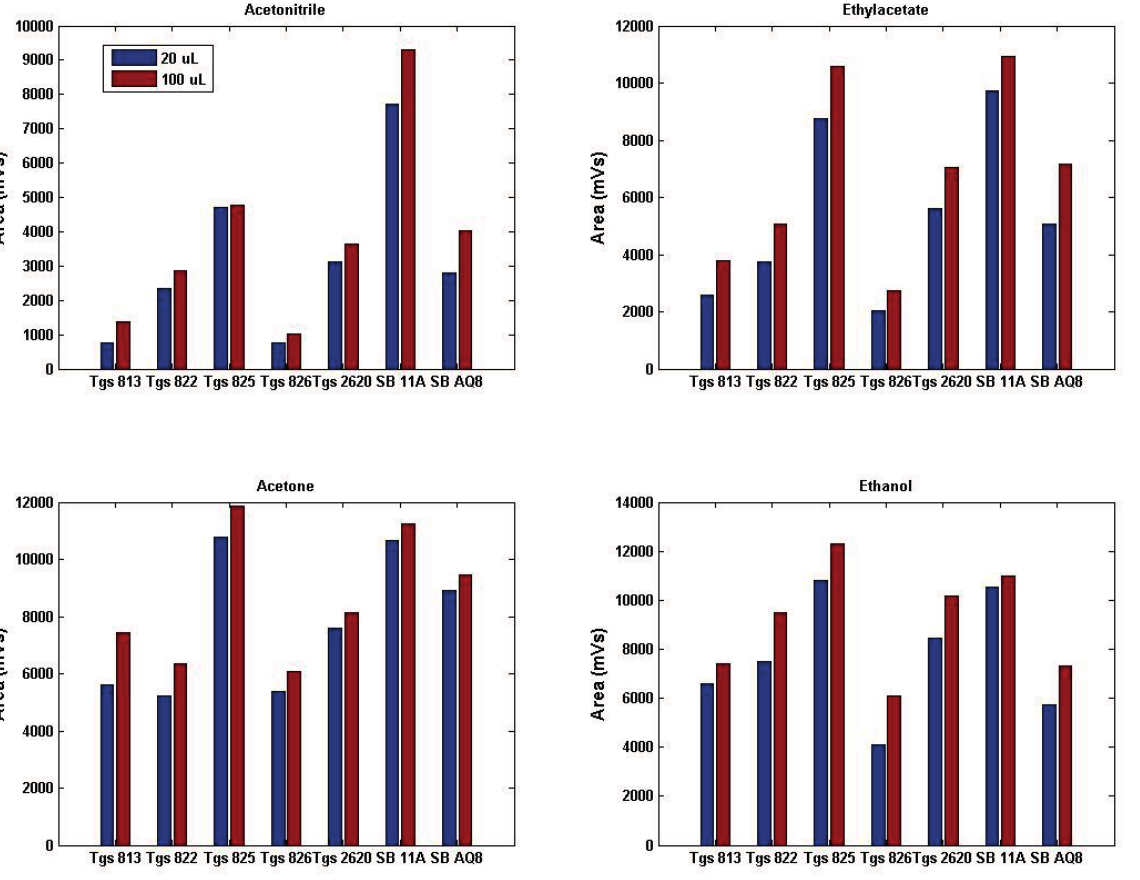
Figure 13. Responses of the gas sensor array to four chemicals at two